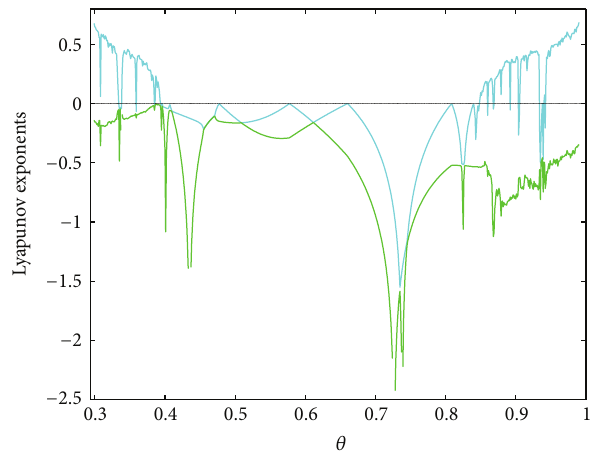
Figure 10: The corresponding Lyapunov exponents diagram with 𝜃 ∈ (0.2937, 1] and 𝛼